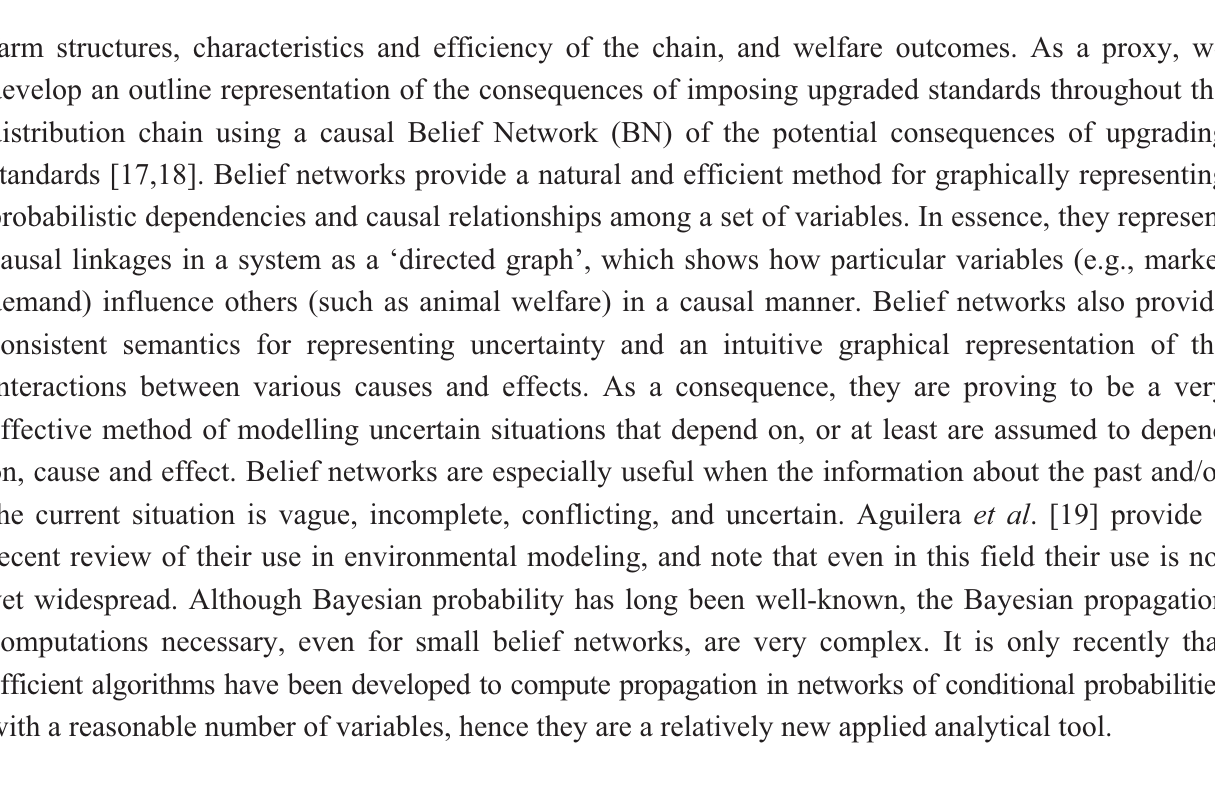
Table 1. Policy objective and instrument priorities for improved animal welfare